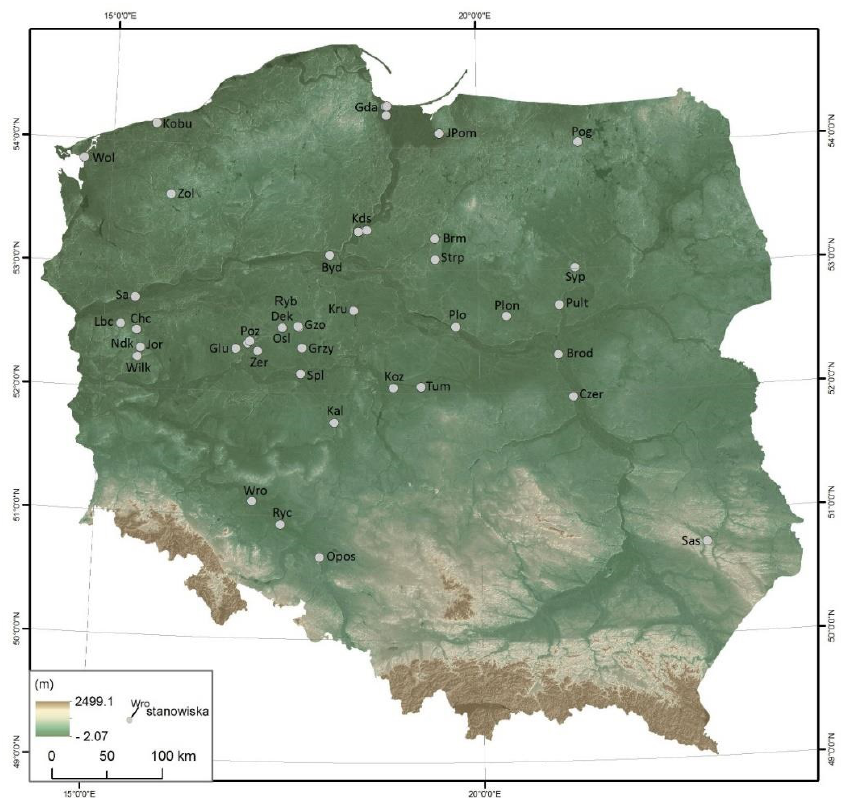
Figure 2. Sites with finds of horse skulls (the acronym of the site is given first, the number or name of the site in the following place, the number of skulls in brackets): Bis — Biskupin 15a — spring (2);